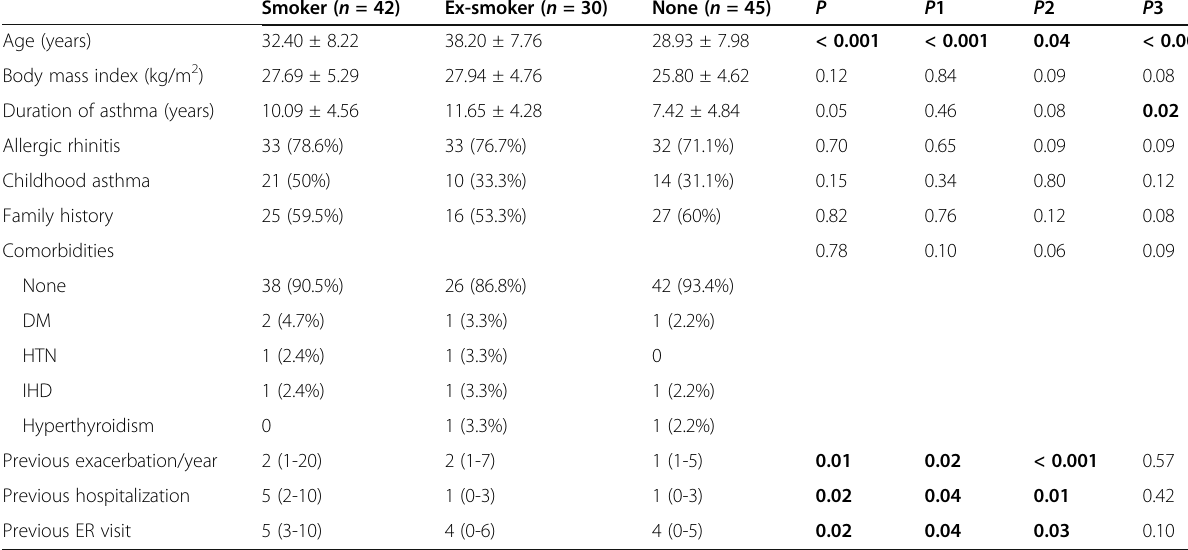
Table 1 Baseline data of studied patients based on smoking state Smoker ( n = 42)